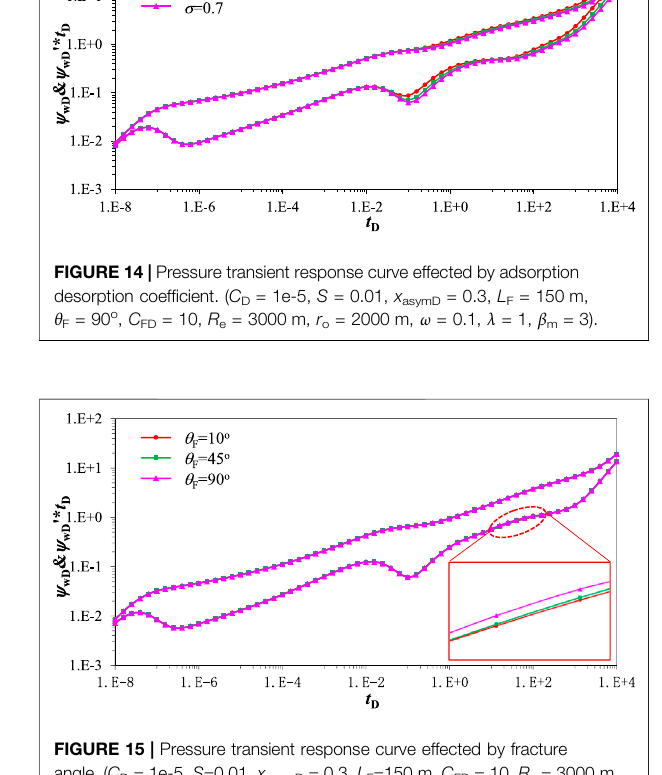
Figure 14 is the pressure transient response curve affected by adsorption-desorption coef fi cient. The adsorption-desorption coef fi cient mainly affects the typical curve shape after the cross fl ow regime. The smaller the value of adsorption- desorption coef fi cient is, the narrower and shallower the “ concave ” on the pressure derivative curve is. On the contrary, the larger the value of the adsorption-desorption coef fi cient is, the wider and deeper the “ concave ” on the pressure derivative curve is. The larger the amount of adsorbed gas in the coal matrix is, the more obvious the characteristics of cross fl ow after desorption are.